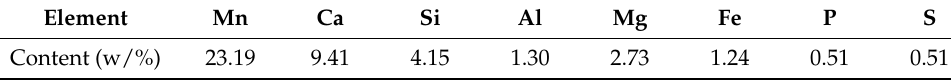
Table 1. The analysis of the content of main elements in calcined manganese ore.